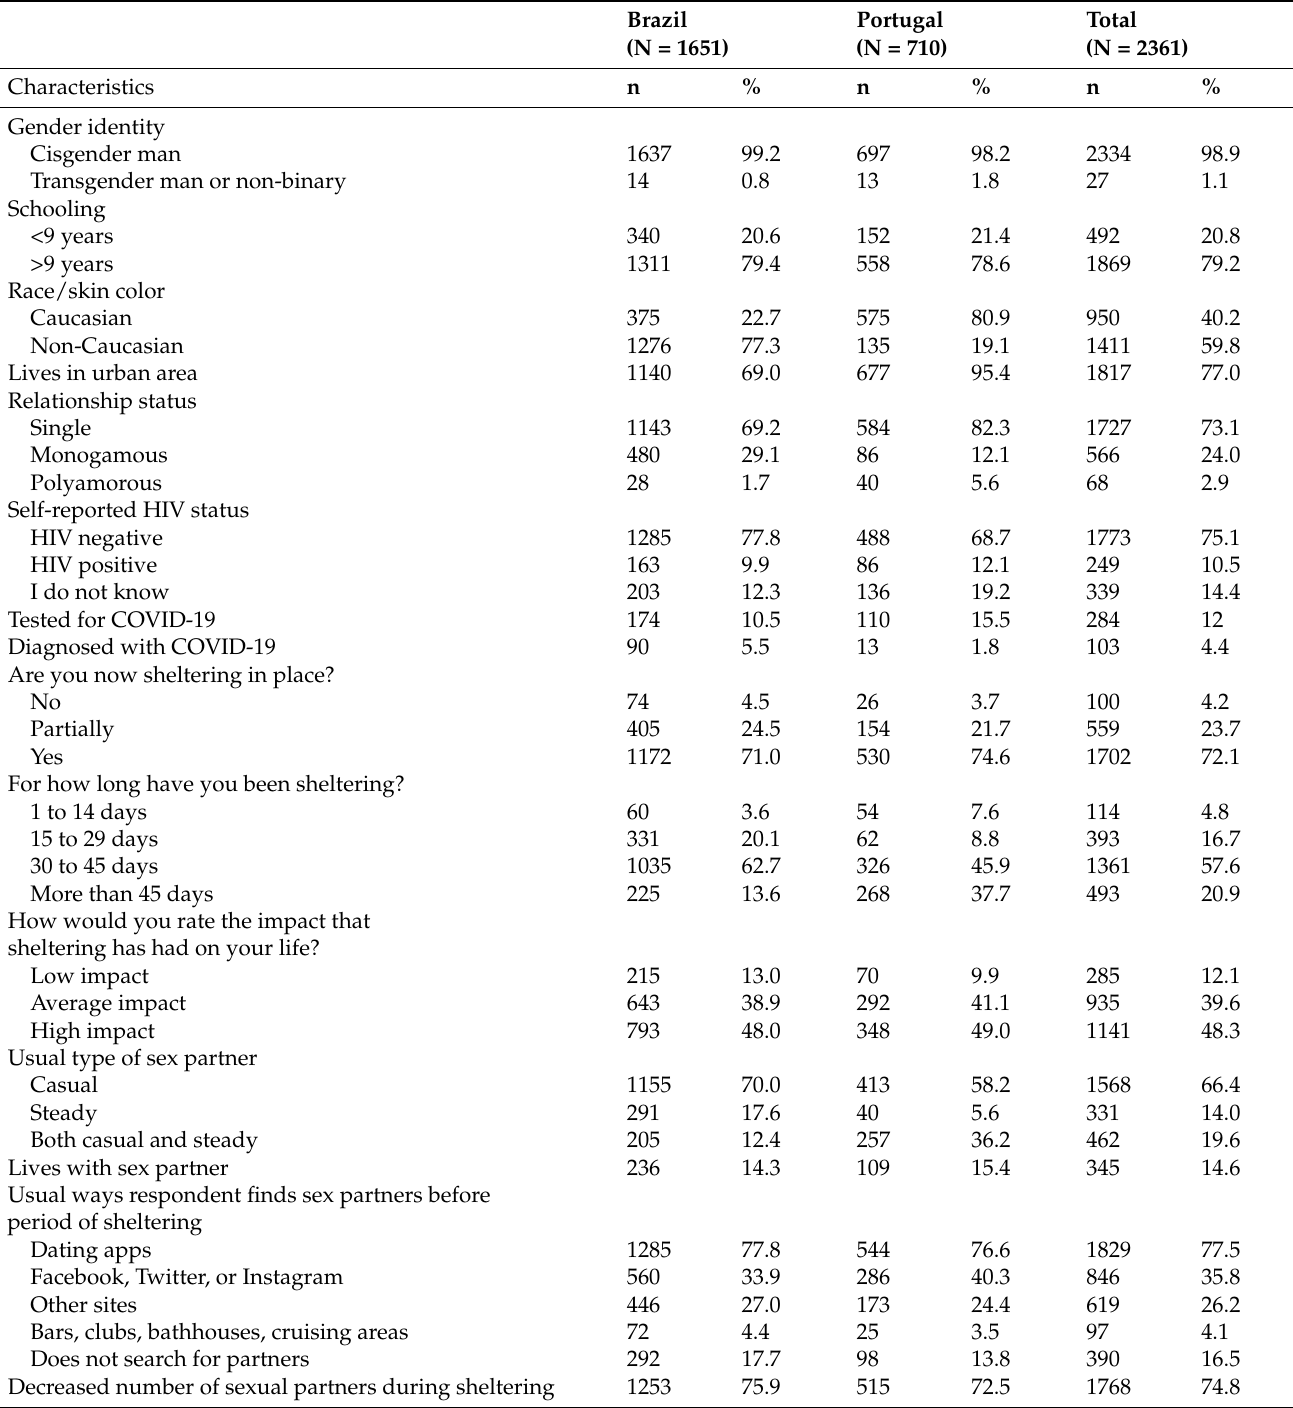
Table 1. Characteristics and sexual practices during the COVID-19 shelter in place period, men who have sex with men, Brazil and Portugal,